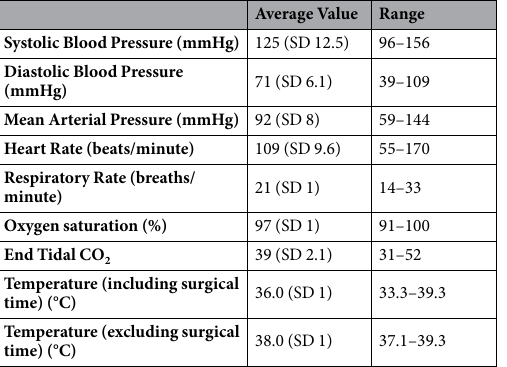
Table 3. Range of Vitals Observed Pre-infection. Overview of observed vital sign ranges. It is important to consider that all blood pressure and heart rate values are potentially affected by sedation medications. Additionally, the lower range of the respiratory rate was set by the ventilator since a minimum rate was set on the machine. Similarly, supplemental oxygen and changes to ventilator settings would have affected O 2 saturation and end tidal CO 2 values. A final consideration is body temperature, which was affected by artificially low ambient temp.